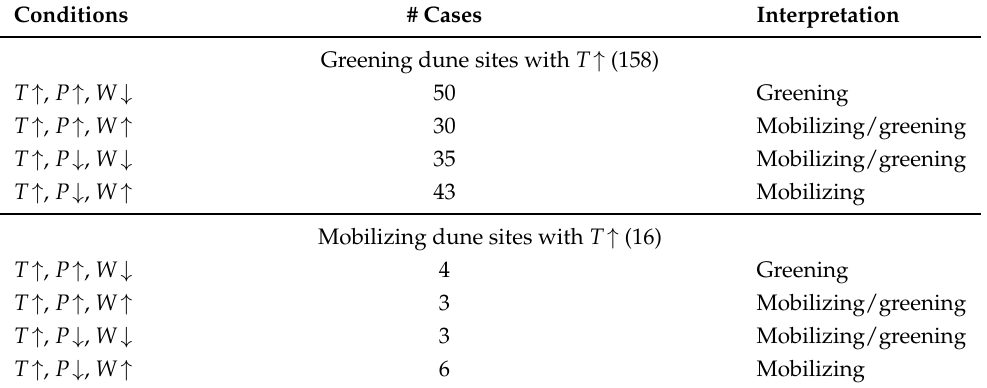
Table 4. Greening and mobilizing dune sites grouped according to change in temperature, precipita- tion and wind